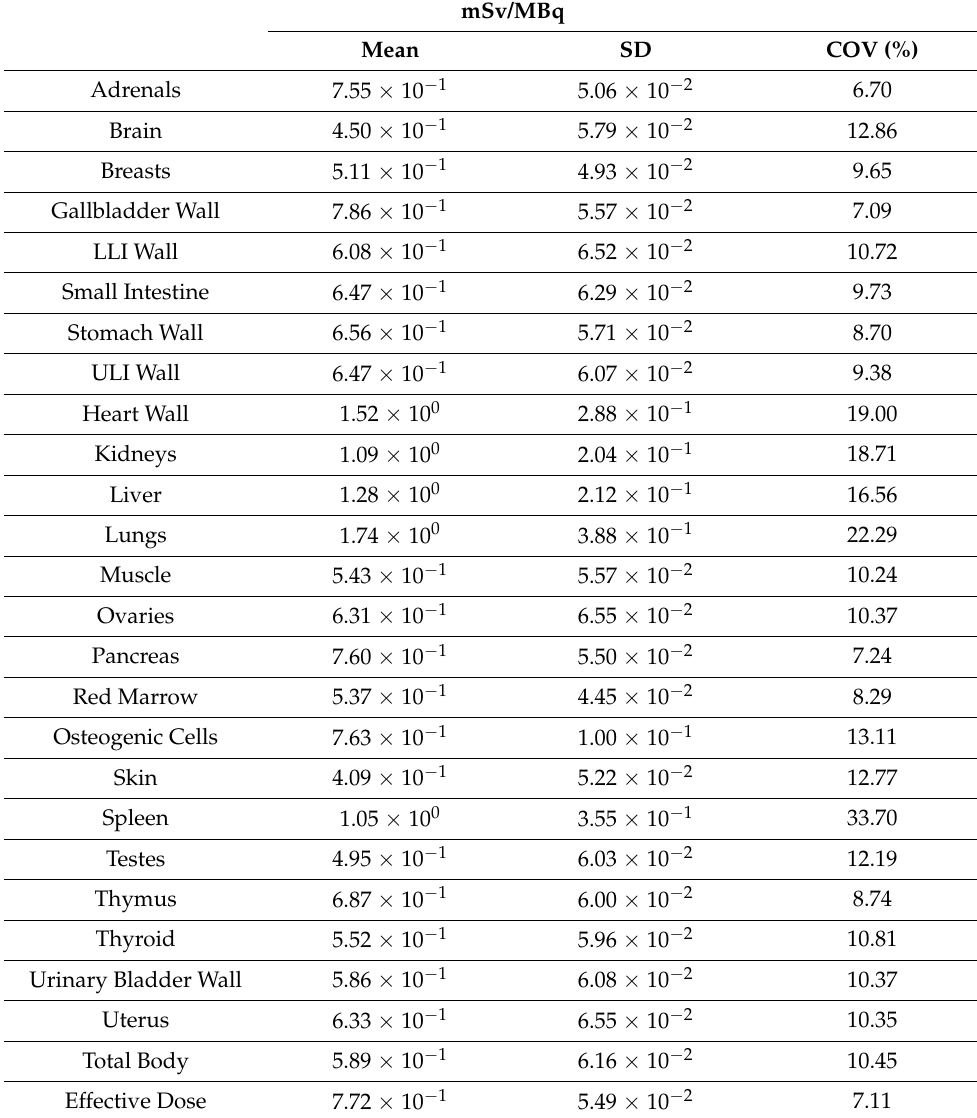
Table 3. Tabulated organ dose estimates for [ 124 I]I-NM404 are presented in units of mSv/MBq. The mean, standard deviation (SD), and coefficient of variation (%) for the patients ( n = 14) is